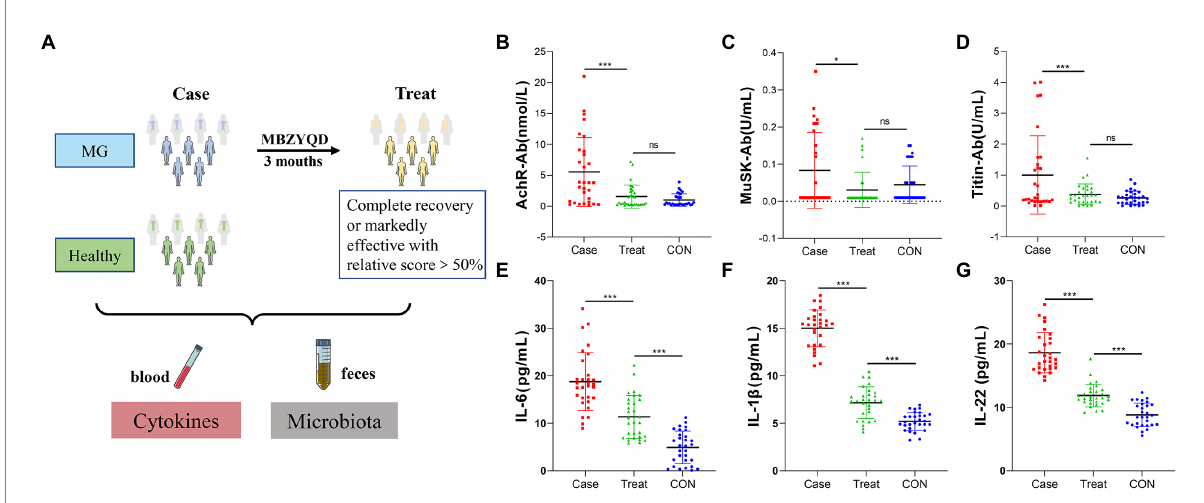
TABLE 1 The clinical symptoms of myasthenia gravis patients before and after treatment. Variables